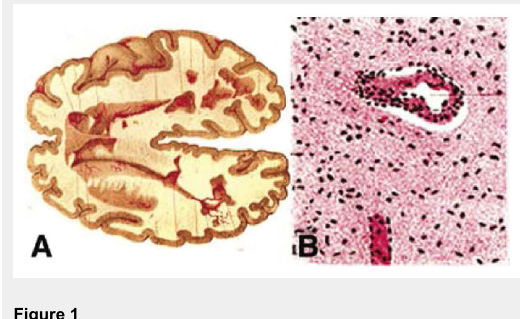
The multiple sclerosis plaque, classical portrayals. A. Plaques embedded in brain white matter (Charcot 1880); B. perivascular and parenchymal inflammatory infiltrates (Babinski, 1885). (from H. Lassmann, Brain Pathol.